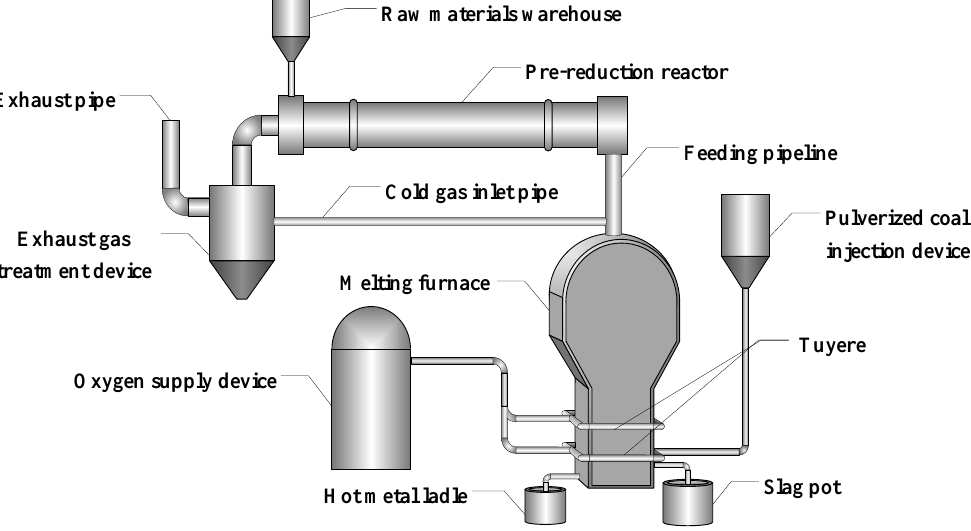
Figure 1. Flow chart of pre-reduction of rotary kiln and total oxygen melting pool process.